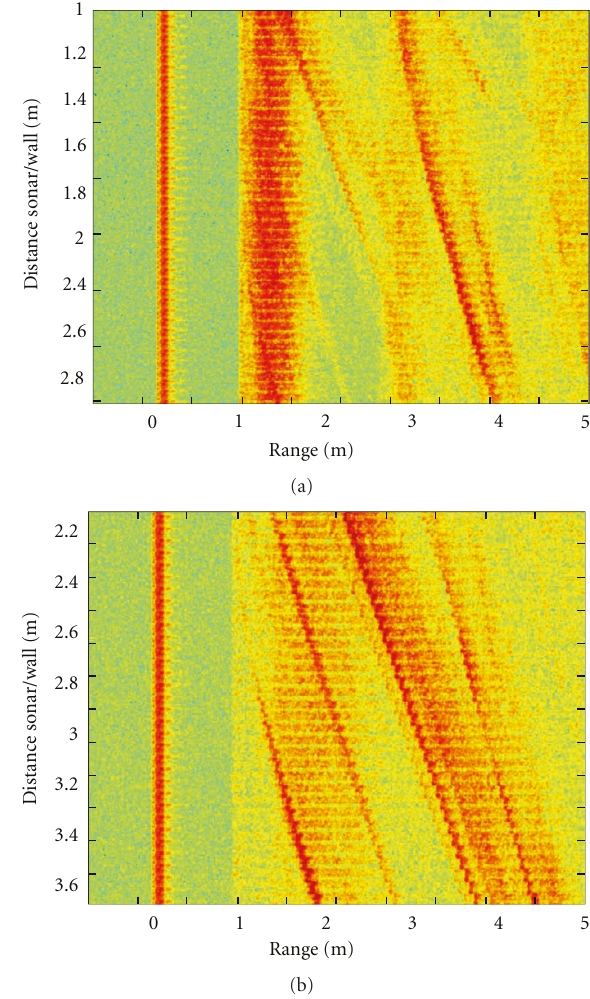
Figure 7: Series of echo responses from cable lying on sediment as sensor is tracked across the tank: (a) 45 ◦ grazing angle; (b) 27 ◦ grazing angle all six DC pulses recorded at each sensor